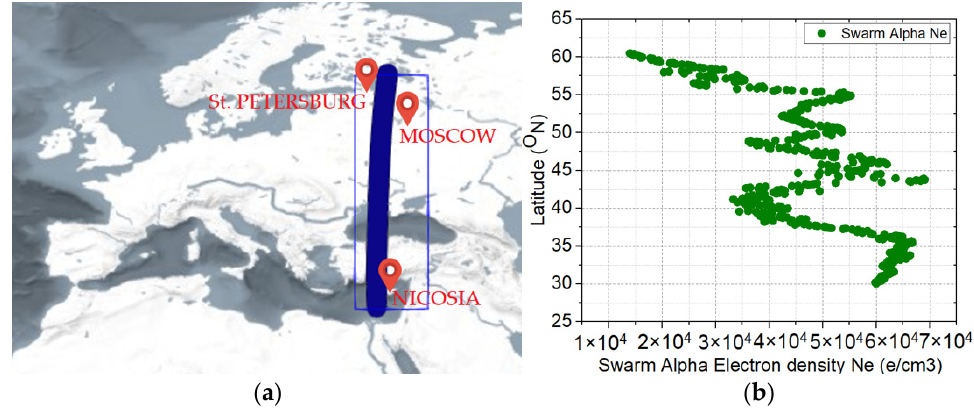
Figure 1. ( a ) Swarm A projection and ( b ) corresponding Ne variation vs. latitude.